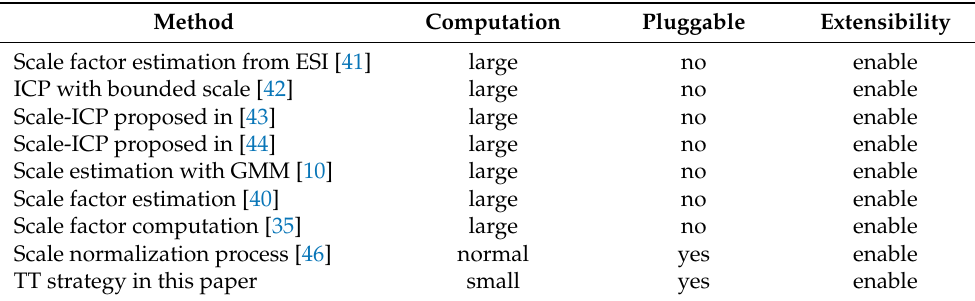
Table 1. The comparison of different methods for extending rigid registration algorithms to isotropic scale